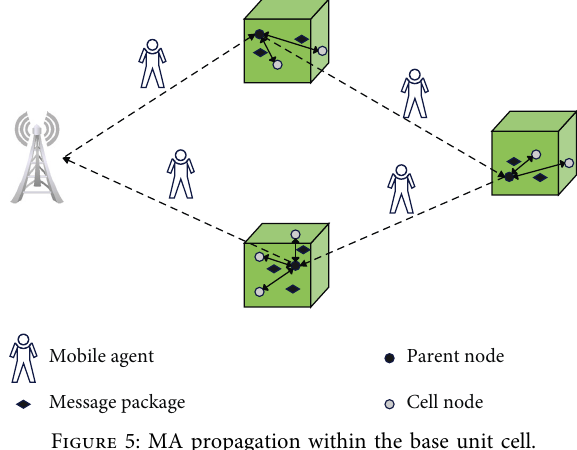
Figure 5: MA propagation within the base unit